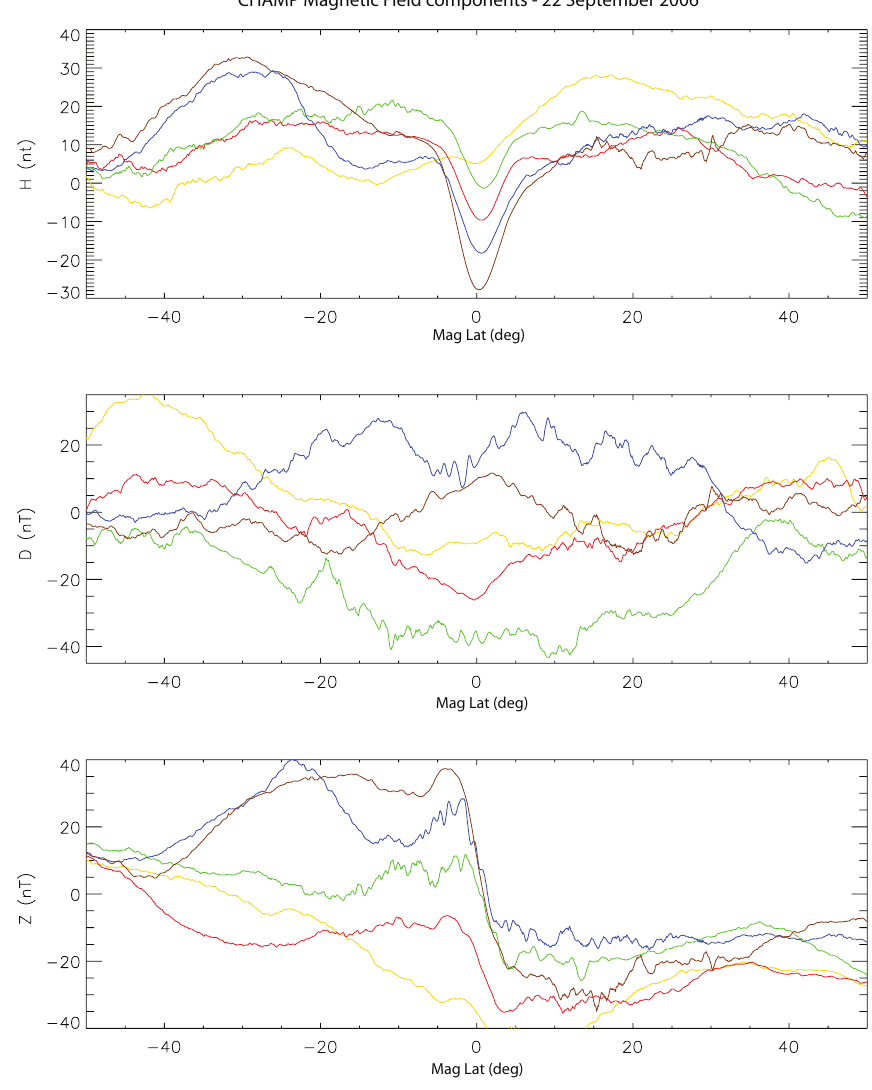
Fig. 3. The same as Fig. 2, but for the 22 September 2006 event.